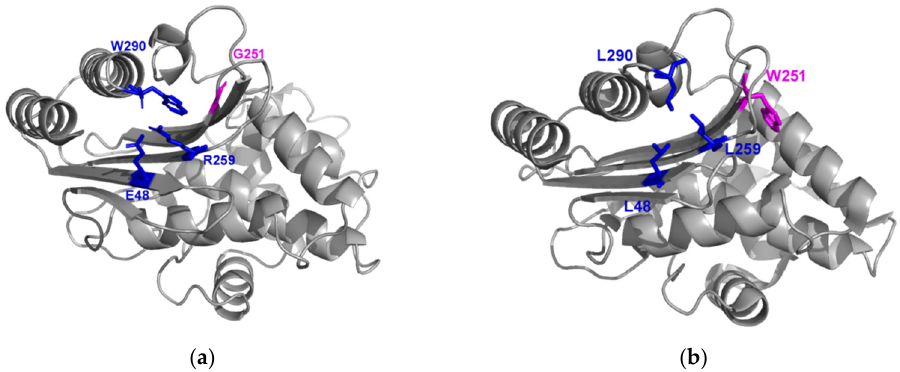
Figure 3. ( a ) Three-dimensional structure of TEM-1 (pdb entry 1BTL). The site G251 is shown in pink, and the 3 residues exclusively associated with G251 (E48, R259, and W290) are indicated in blue. ( b ) Three-dimensional structure of CTX-M-15 (pdb entry 4HBT). The site W251 is shown in pink, and the 3 residues associated with W251 (L48, L259, and L290) are indicated in blue.